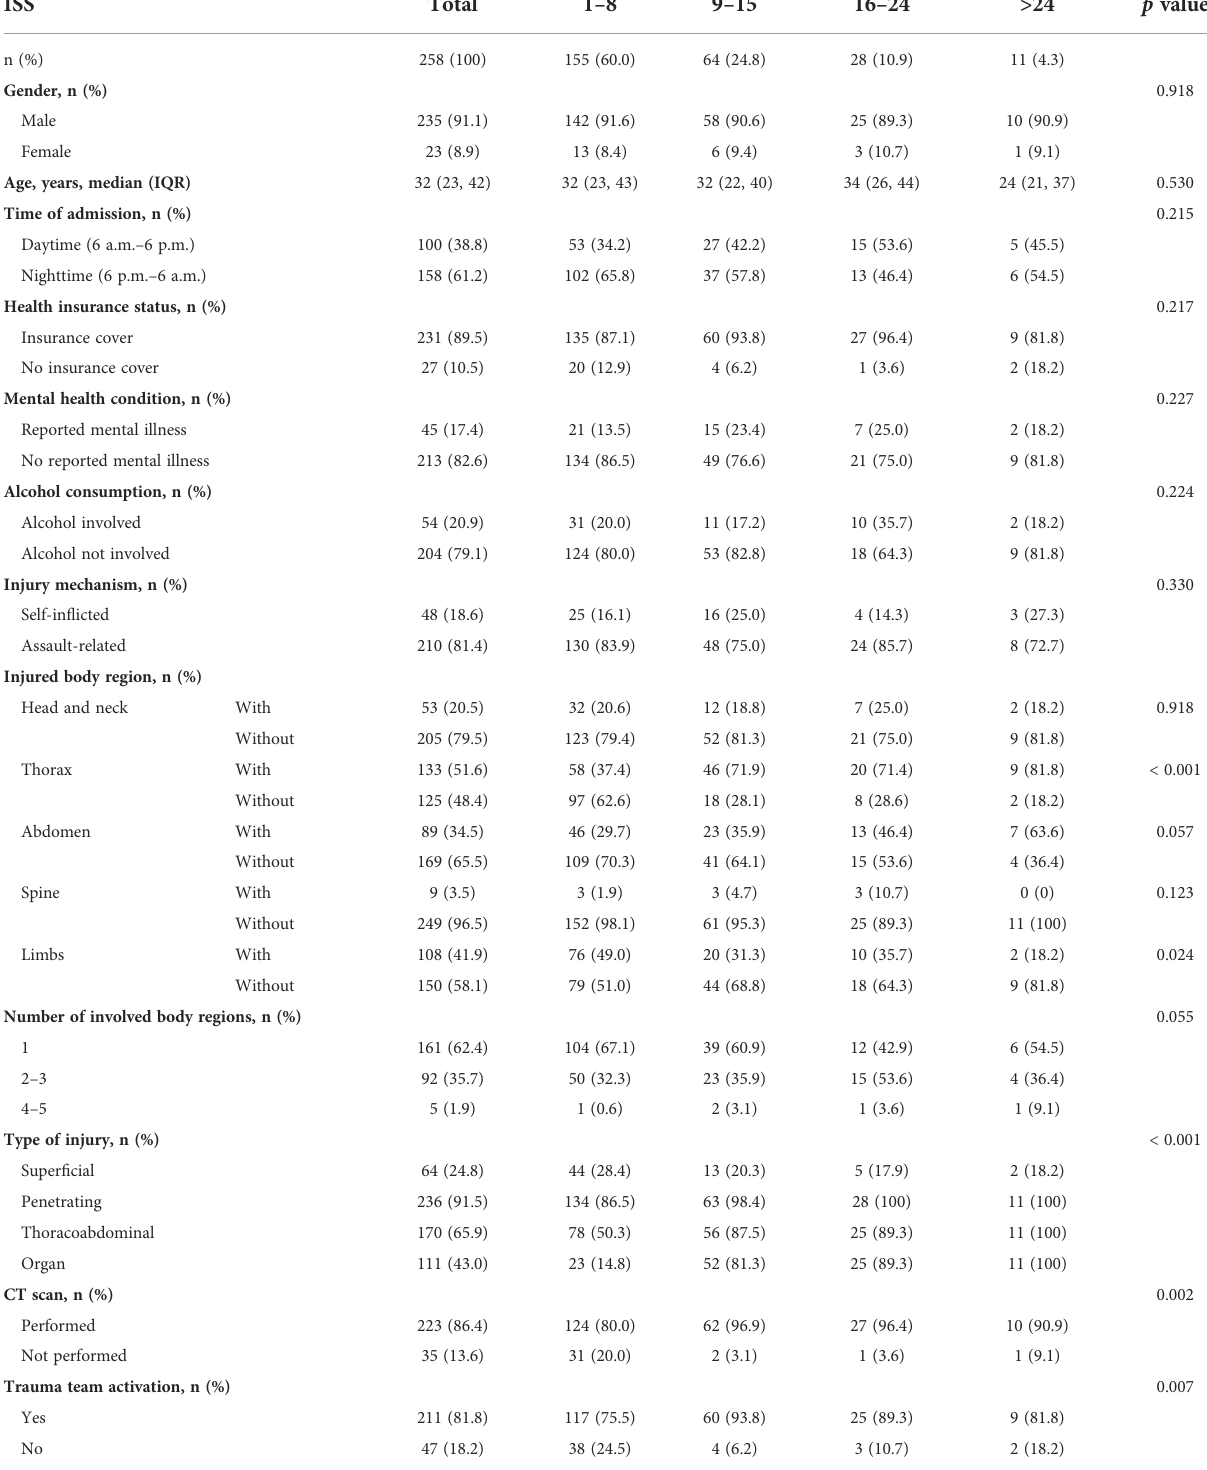
TABLE 1 Characteristics of patients who suffered stab injuries between July 2015 and December 2021 at a Level I Trauma Center in Berlin,